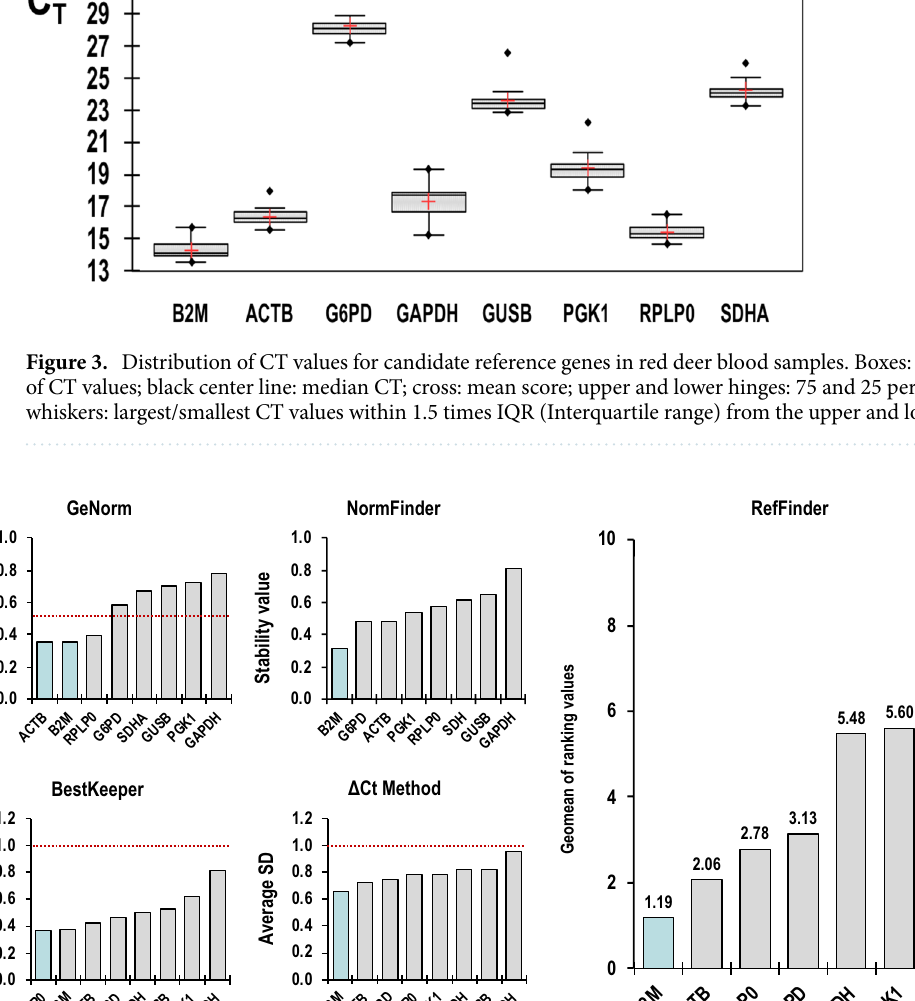
Figure 4. Stability ranking of candidate reference genes. The final overall ranking of the eight candidate reference genes using the RefFinder tool, and the expression stability of the genes calculated using geNorm, NormFinder, BestKeeper and the comparative ΔCT (available in RefFinder). Within each graph, the most stable gene is on the left (highlighted bar) and stability decreases towards the right. The dotted line indicates the cut-off